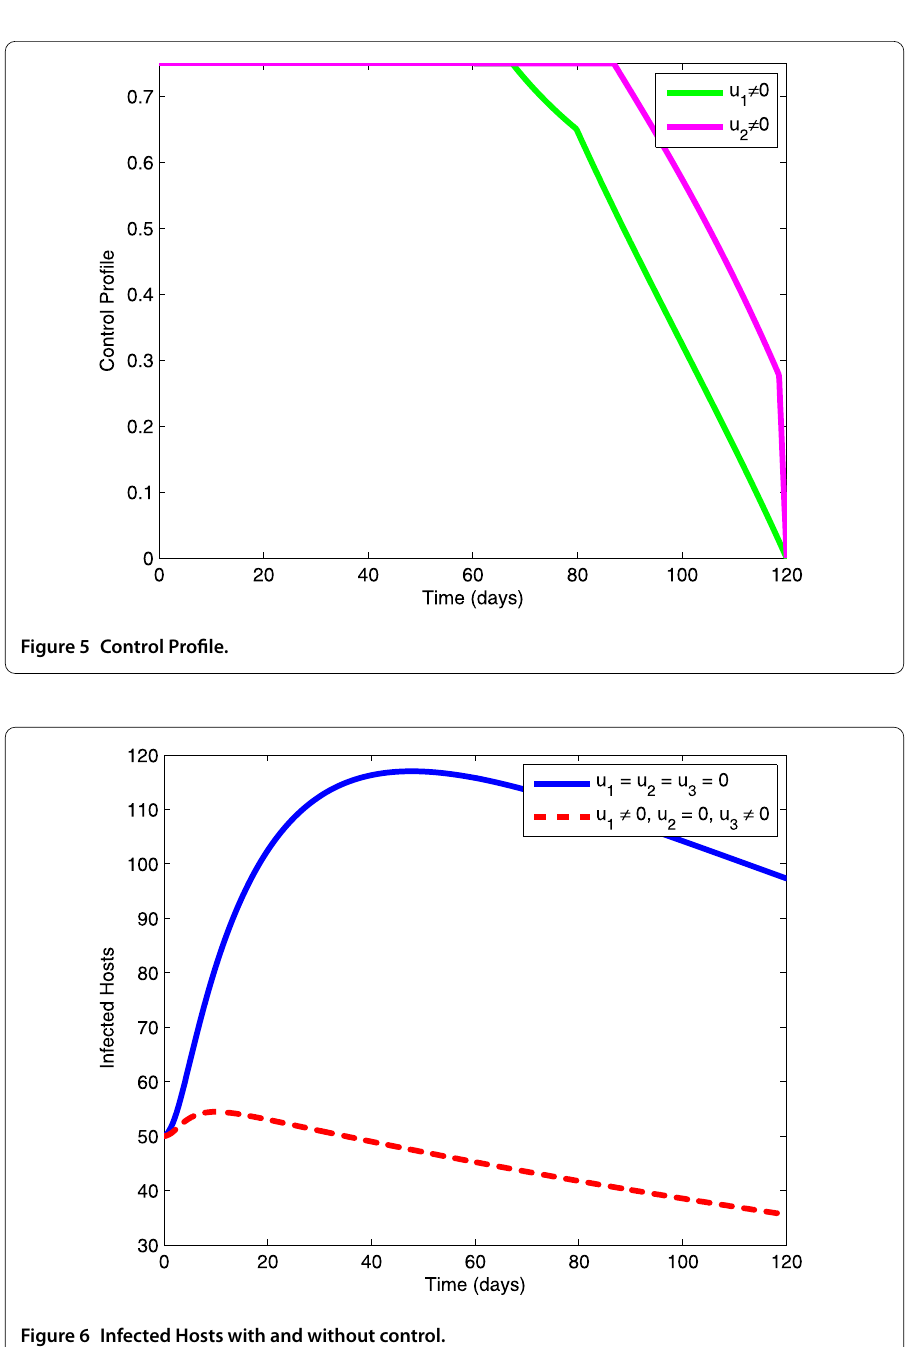
Figure 6 Infected Hosts with and without